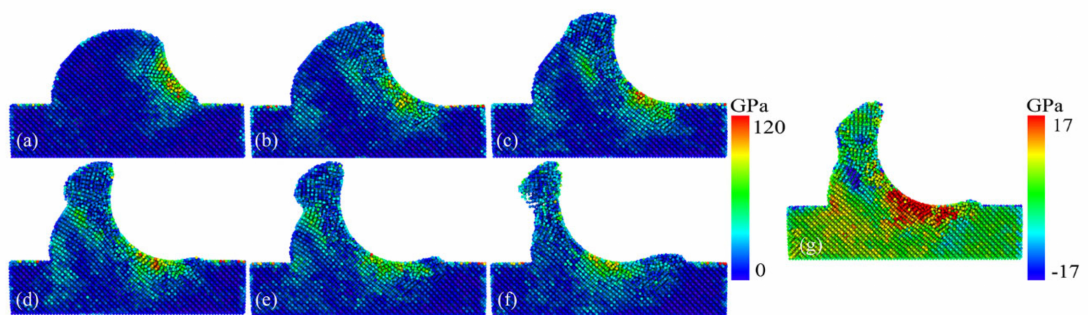
Figure 6. Distribution of von Mises stresses at plowing distance of ( a ) 4 nm, ( b ) 6 nm, ( c ) 7 nm, ( d ) 9 nm, ( e ) 10 nm and ( f ) 12 nm and ( g ) the hydrostatic stress at the highest tensile stress